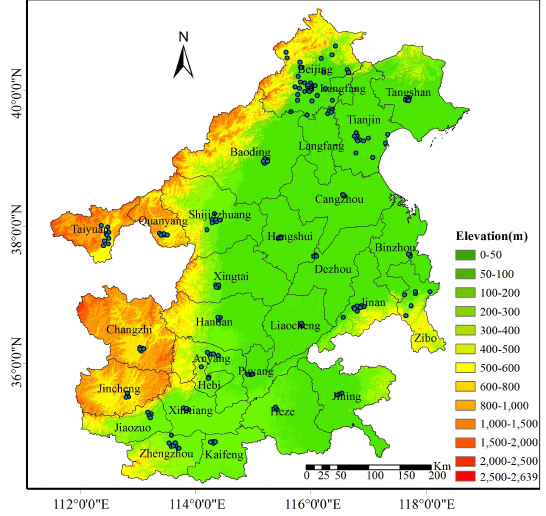
Figure 1. The geographical location of the ‘2+26’cities The terrain of the whole region is high in the west and low in the east. Taihang Mountain is the main mountain range. The central and eastern regions are plains and basins, and the